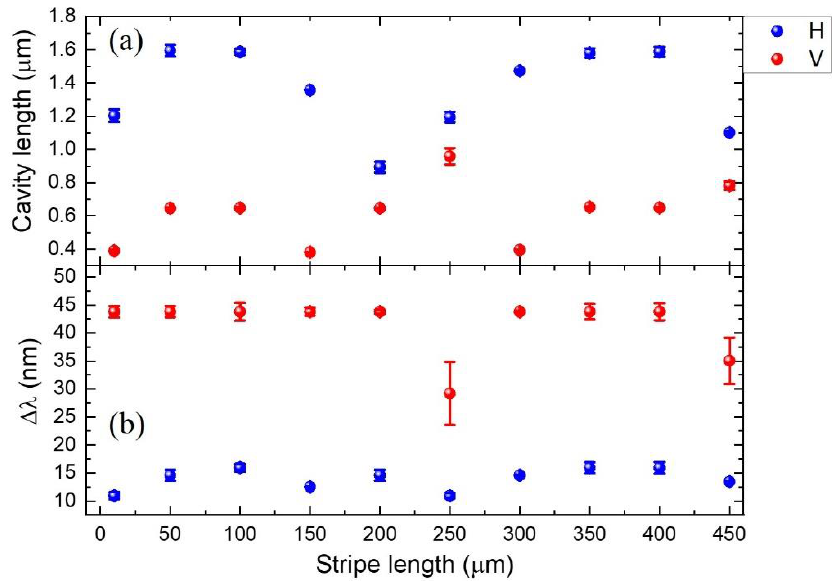
Figure 4. ( a ) Cavity length and ( b ) mode spacing under H- and V-polarized excitation were plotted for increasing stripe length.